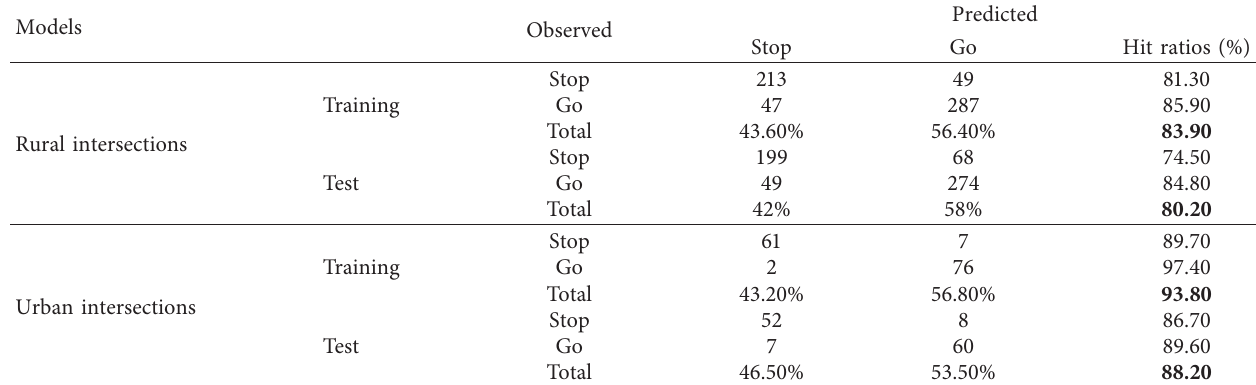
Table 5: Precision of models for rural intersections and urban